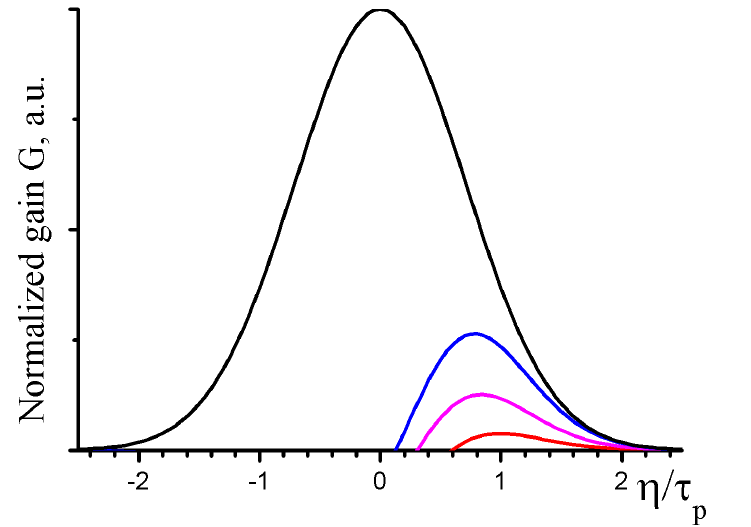
Figure 5. Normalized gain of the four-wave mixing process as a function of eigen time coordinate η of the pump KrF laser pulse. The gain curves correspond to the pump pulse areas exceeding the threshold value by 25% (red), 50% (magenta) and 75% (blue), respectively. For comparison, the pump pulse Gaussian envelope is shown by the black